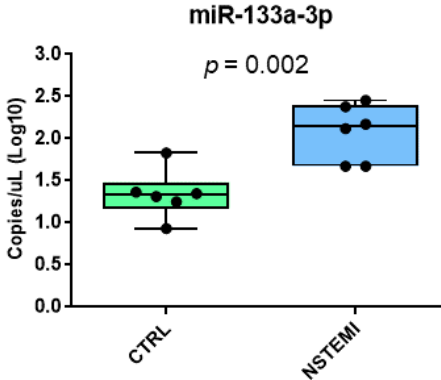
Figure 4. Plasma miRNA evaluation in a clinical setting. Plasma miR-133a-3p expression in healthy subjects (CTRL) and non-ST-segment-elevation-myocardial-infarction (NSTEMI)